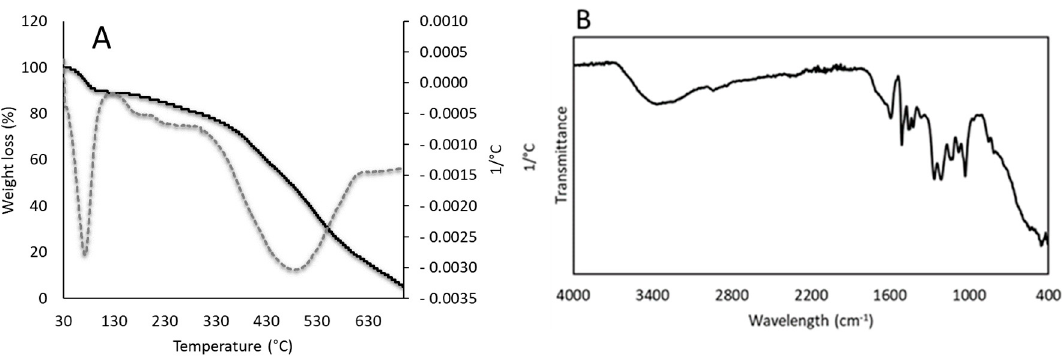
Figure 2. TGA and DTGA curves ( A ) and FTIR spectra ( B ) of the obtained kraft lignin. Fourier transform infrared (FTIR) analysis of lignin obtained in the region of 4000 to 400 cm − 1 is shown in Figure 2B. The lignin sample exhibited a characteristic broad peak within the range between 3600 and 3400 cm − 1 corresponding to both aromatic and ali- phatic hydroxyl groups present in lignin. The band observed at around 2900 cm − 1 may be